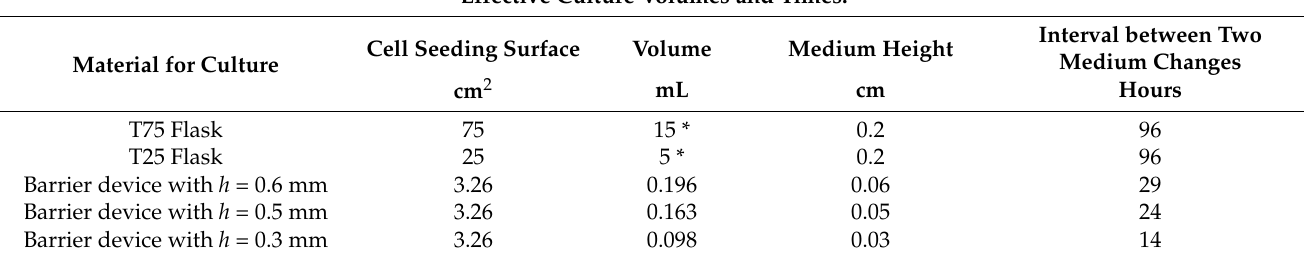
Table 1. Comparison of effective culture volumes and times between flasks and our home-made device (including further proposed heights of the upper channel ( h )). Medium heights in flasks were calculated by dividing the volume by the cell surface, while medium heights in devices corresponded to the height of the upper channel as it was filled with medium. Interval between medium change in flask corresponds to 50 µ L/cm 2 /day. * Usual volumes recommended by the supplier. (Wells and Transwell ® cannot be taken into consideration because of the bias of the meniscus